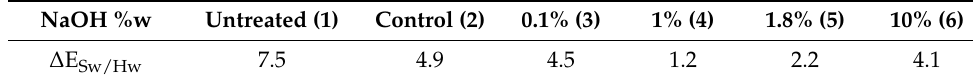
Table 2. Influence of NaOH concentration on Δ E Sw/Hw values.